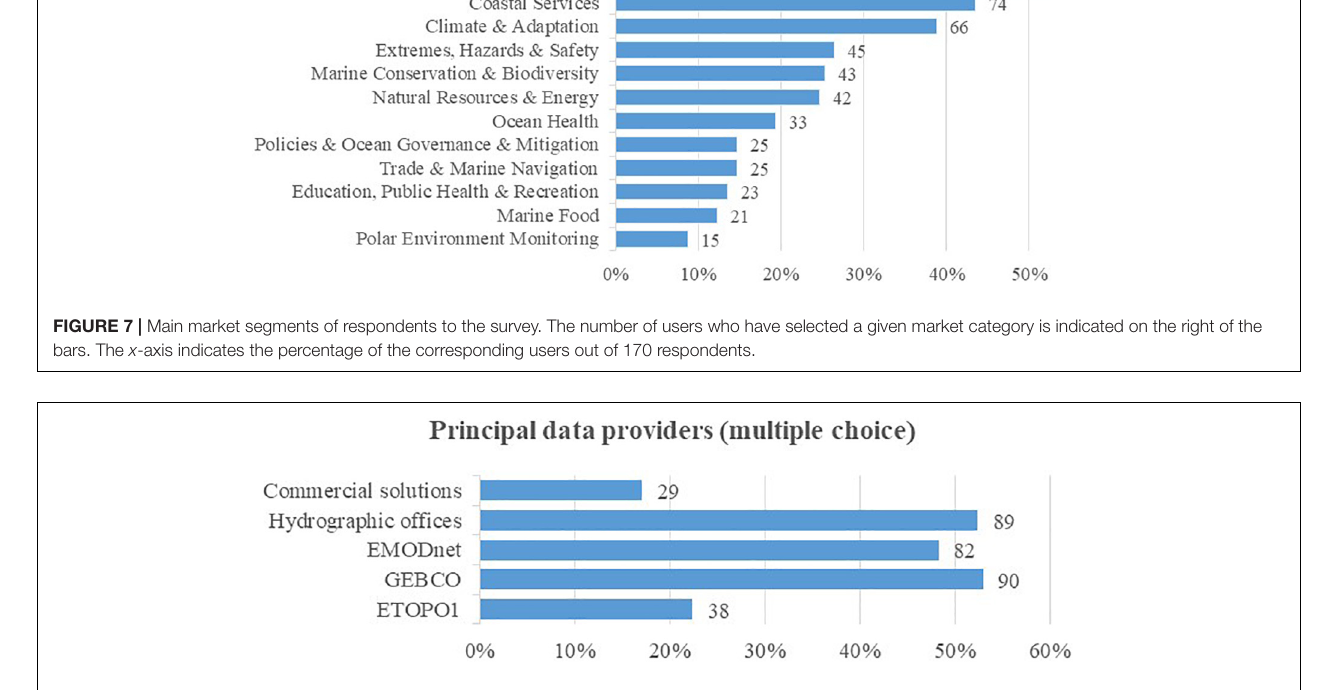
FIGURE 8 | Principal data